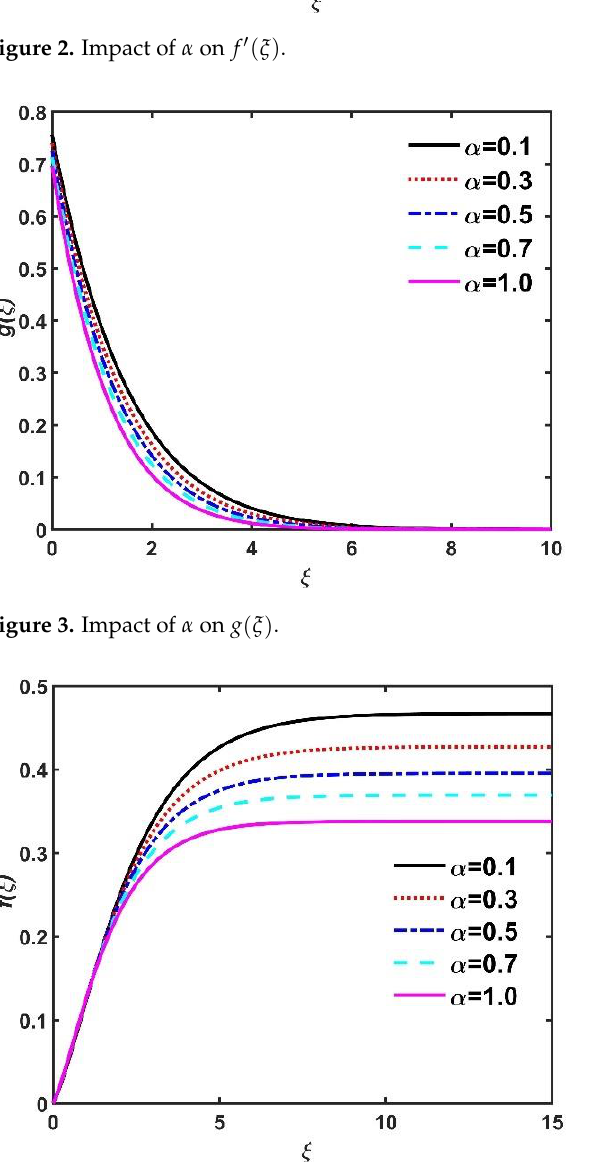
Figure 5. Impact of 𝛼 on 𝜃(𝜉) . Figures 2 – 5 exemplify the radial velocity ( 𝑓′(𝜉) ), azimuth velocity ( 𝑔(𝜉) ), axial veloc- ity ( 𝑓(𝜉) ), and temperature ( 𝜃(𝜉) ) for several values of the relaxation time – retardation time ratio ( 𝛼 ). As the values of 𝛼 increase, the retardation time lessens, meaning that Jef- frey fluid molecules need more time to achieve a state of equilibrium after being in a per- turbed state. Because of this, a decrease in the momentum of the surface layer in the axial ( 𝑧 ), azimuth ( 𝜑 ), and radial ( 𝑟 ) directions was observed. Significant expansion of the tem- perature surface layer width was observed (shown in Figure 5) by increasing the magni- tude of 𝛼 from 0.1 (a relatively small value) to 1.0 (a relatively high value). The reason for this is that a longer relaxation time leads to an increase in the Jeffrey fluid temperature ( 𝜃(𝜉) ). Figure 6 shows the radial velocity ( 𝑓′(𝜉) ) when varying 𝛽 , where the performance was found to improve twofold. That is, in the vicinity of the disk surface, radial velocity 𝑓′(𝜉) condensed, augmenting the 𝛽 values, whereas the radial velocity 𝑓′(𝜉) remained unchanged in the rest of the flow domain. The radial velocity profile showed dual behav- ior with variation of 𝛽 . This is because the Coriolis force exerted by the rotation of the disk leads to radial outward flow in the vicinity of the disk. When nearing an ambient state, radial velocity approaches zero, with a crossover in the middle of the flow region. The Deborah number ( 𝛽 ) and retardation time are directly proportional, so 𝑓′(𝜉) is en- hanced with 𝛽 . In Figure 7, it is evident that the azimuth velocity ( 𝑔(𝜉) ) lessens for cumu- lative values of 𝛽 . However, in Figure 8, axial momentum ( 𝑓(𝜉) ) can be seen to exhibit a